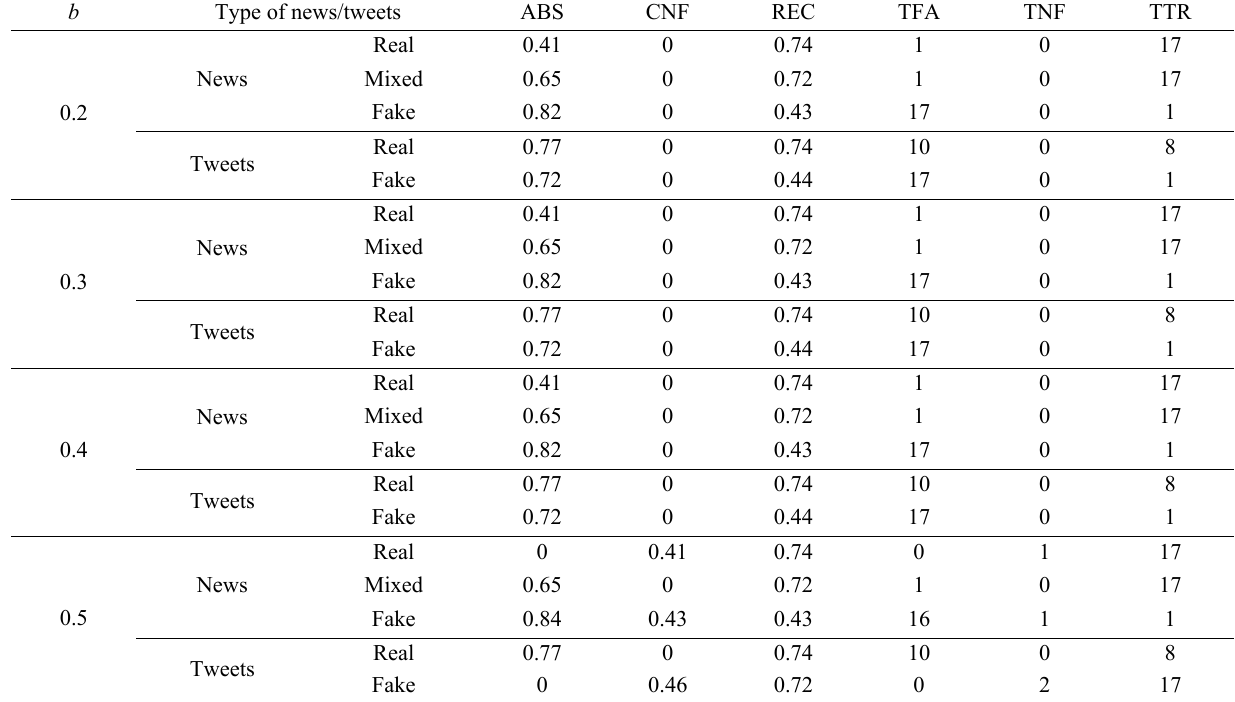
Table 7 Absorption (ABS), community non-functioning (CNF), recovery (REC), time for absorption (TFA), time under community non-functioning (TNF), and time to recovery (TTR) for news and tweets with the critical wellbeing functionality threshold b varying over the range of